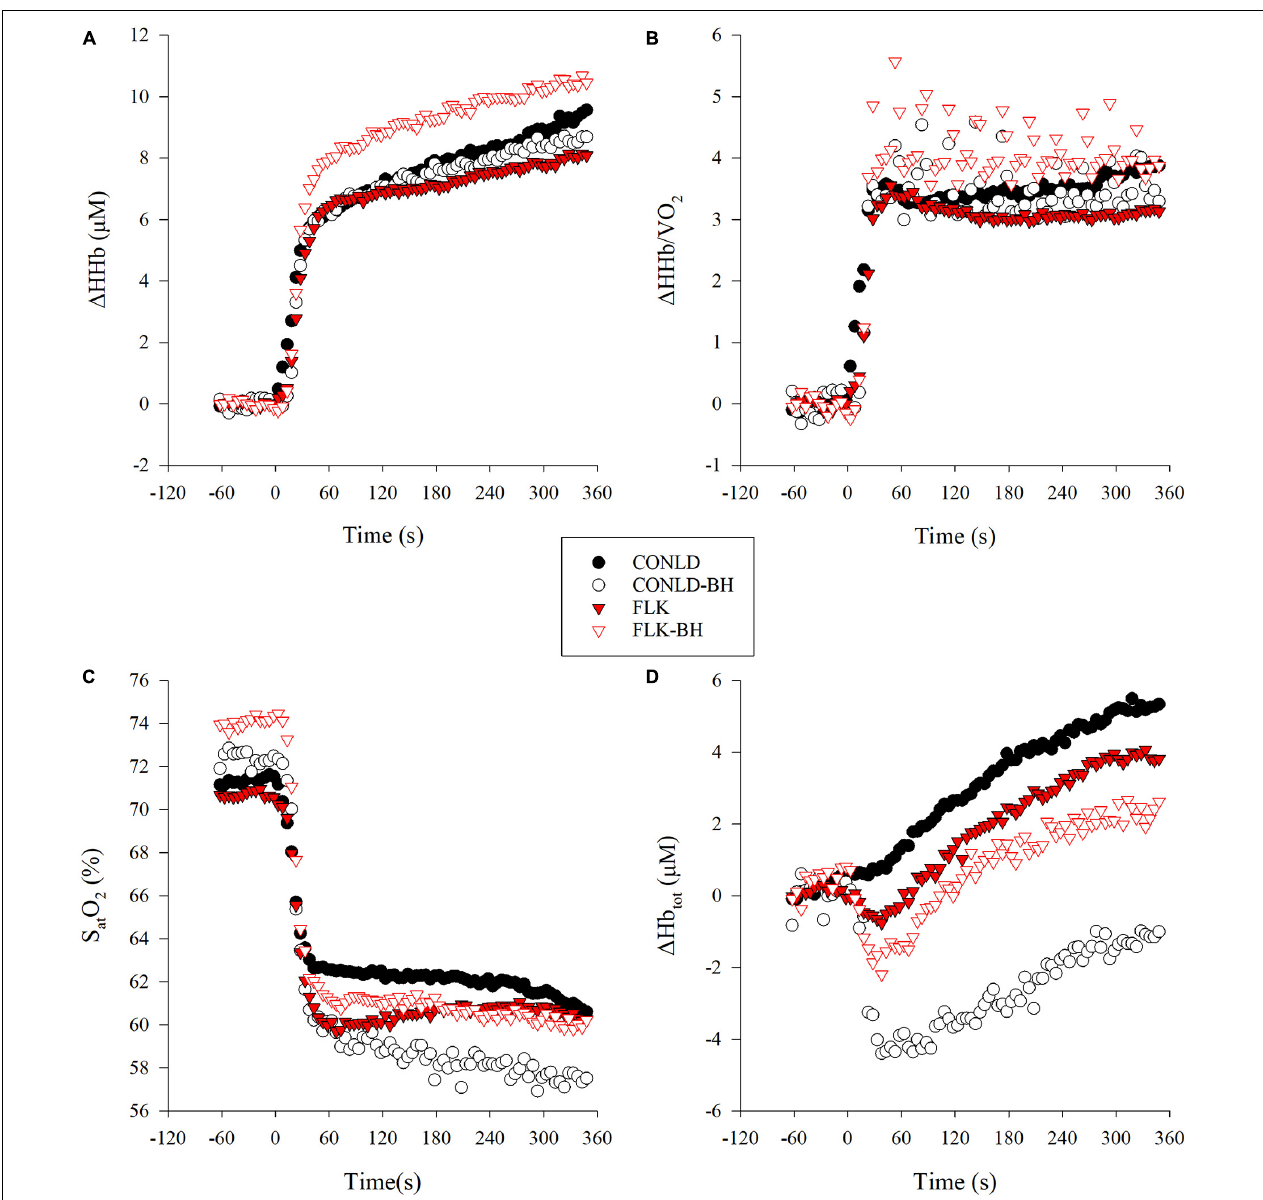
FIGURE 3 | Local muscle deoxygenation variables from near infrared spectrometry (NIRS) data in CONLD (filled circles), CONLD-BH (open circles), FLK (filled red triangles), and FLK-BH (open red triangles). (A) Deoxyhemoglobin concentration normalized to baseline ( (cid:49) [HHb]), (B) ratio of normalized deoxyhemoglobin to VO 2 ( (cid:49) [HHb]/VO 2 ), (C) oxygen saturation of hemoglobin S at O 2 , and (D) total hemoglobin concentration normalized to baseline ( (cid:49) [Hb tot ]). Time 0 marks the start of the exercise transition. Data were interpolated from breath-by-breath to second-by-second and 5 s averaged for graphical